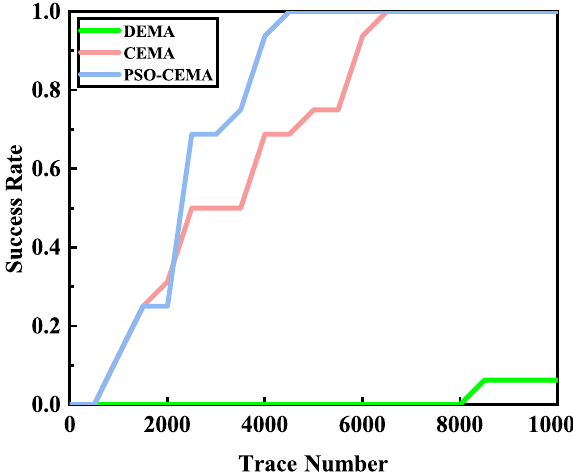
Figure 10. Success rate of different methods. From an attacker aspect, it is better to recover the secret key with less electromagnetic traces. Thus, we used thousands of electromagnetic radiation traces to verify our PSO- CEMA method’s efficiency. In order to highlight the advantage of PSO-CEMA